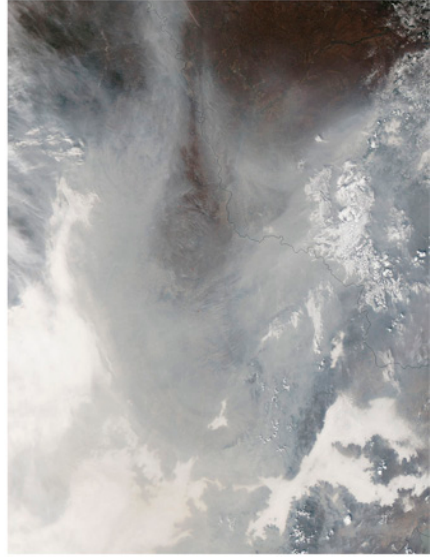
Figure 1. Northeastern China Figure 1 . Northeastern China smog